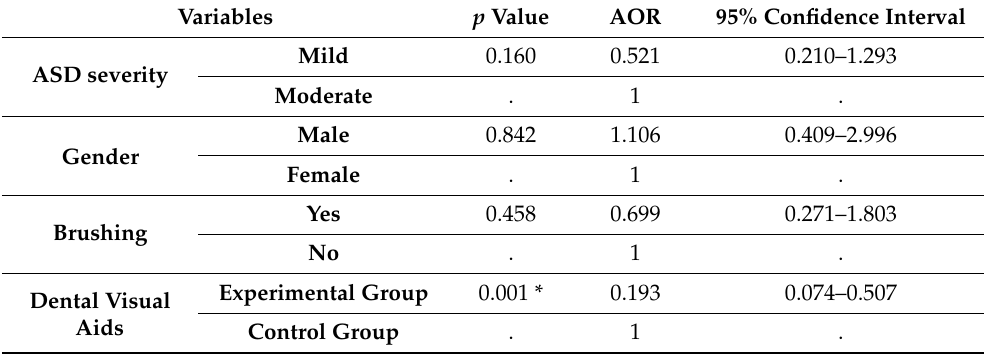
Table 6. Ordinal regression analysis assessing the association between oral hygiene status after the use of the dental visual aids and the type of dental visual aids, ASD severity, gender, and tooth brushing as